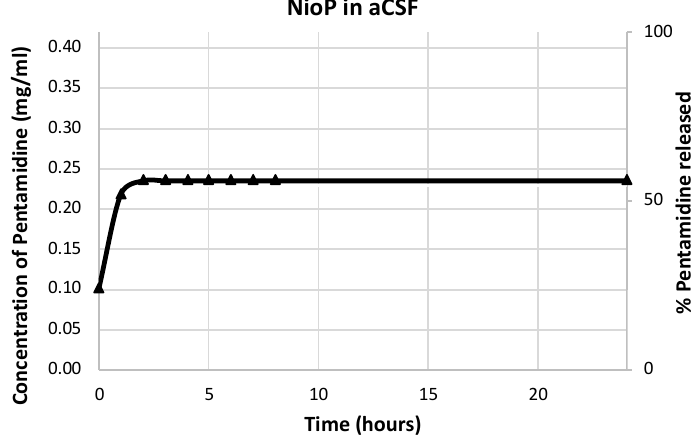
Figure 10. release profile of pentamidine by CG-Nio expressed as concentration or percentage of pentamidine